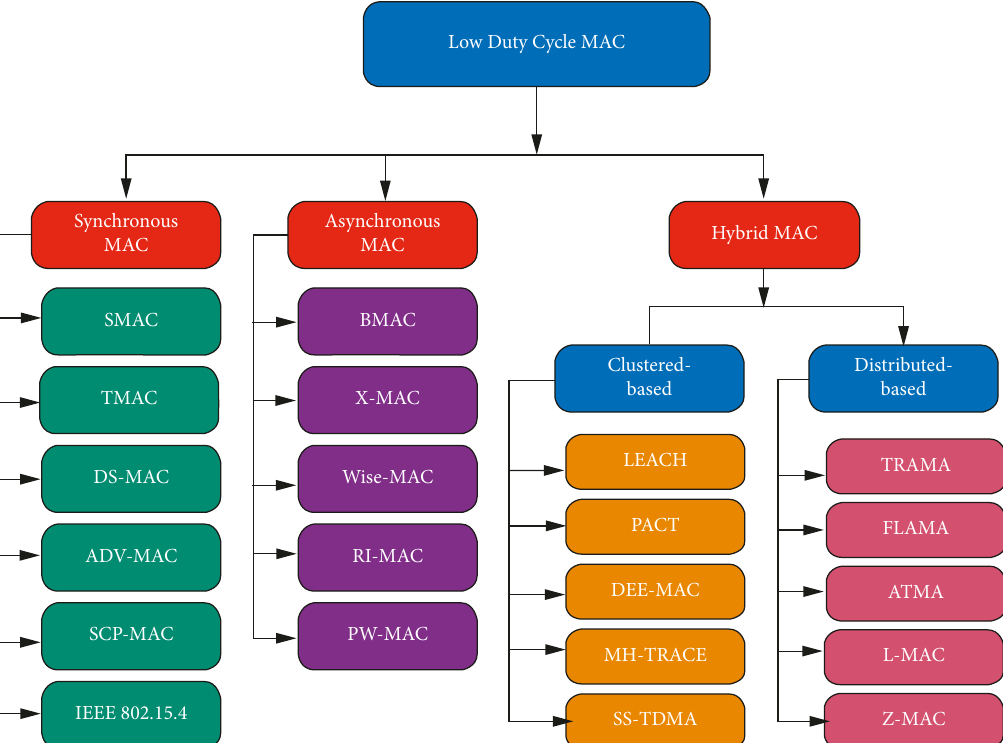
Figure 5: Low duty cycle MAC protocols for WSN.